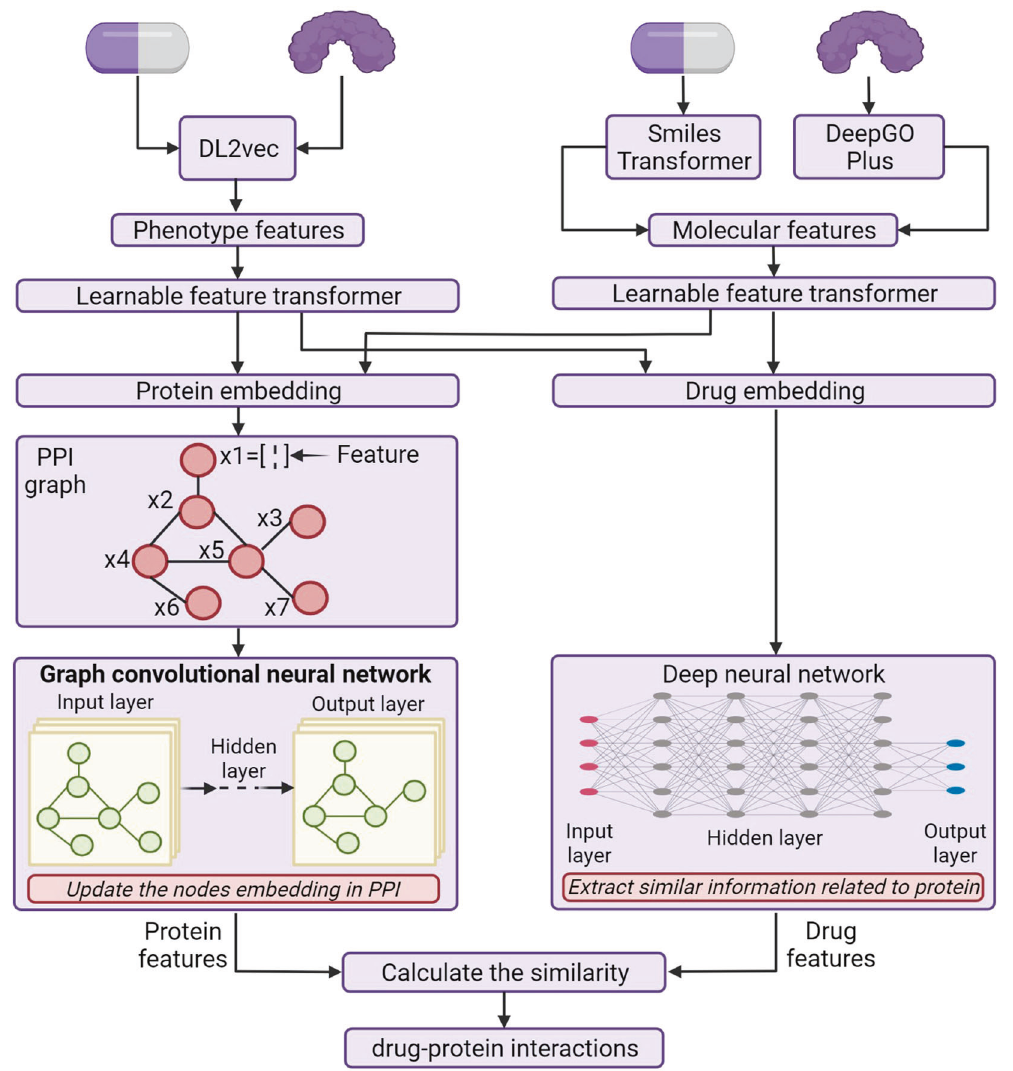
Fig. 11 The graph-based neural network for DTI prediction by combining both bottom-up and top-down biology analysis approaches. (Created with